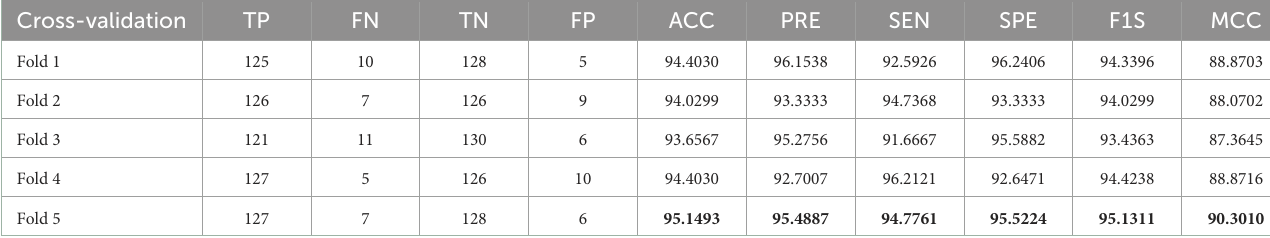
TABLE 5 Outcome of VGG16 with SoftMax for a 5-fold cross-validation.